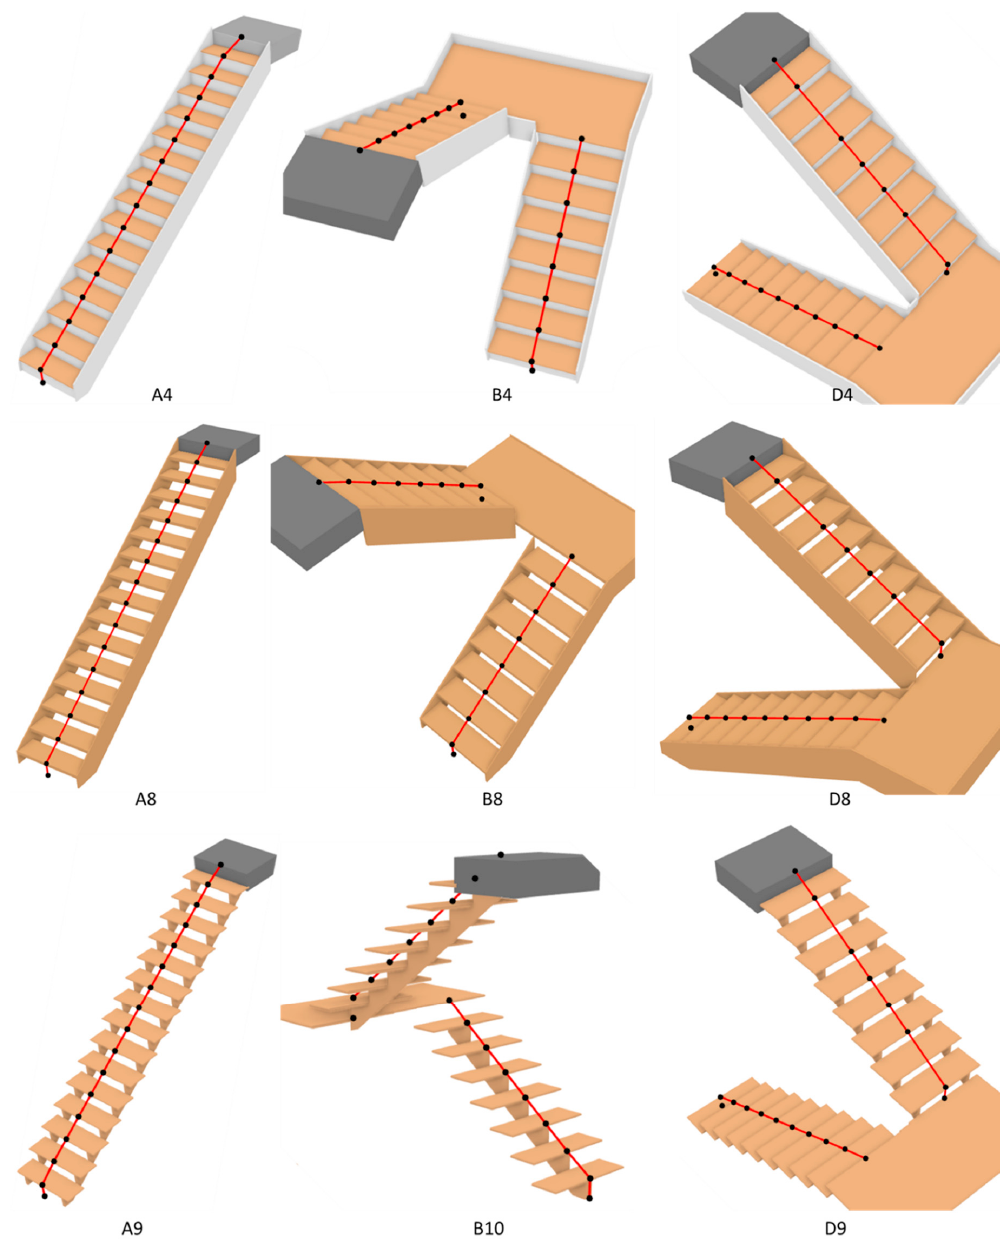
Figure 19. The test results for Groups 4–6.